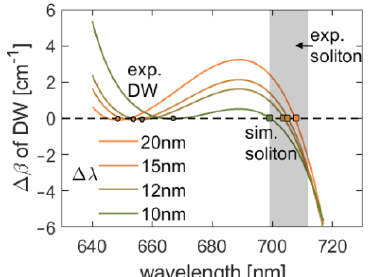
Figure 4. The calculated phase-mismatching rate of DW generation Δβ DW in the same second order PBG as the pump for different spectral distances Δλ ( γ = 6.5 W − 1 /km, pulse: 100 fs, 80 MHz) using Equation (2). The wavelengths of DWs are taken from the experiments and the P sol is calculated from the DW generation threshold. The corresponding soliton wavelengths are obtained by the crossing of the individual curves with the zero line ( Δβ = 0), corresponding to DW-PM. The gray area means the soliton wavelengths taken from experiment.